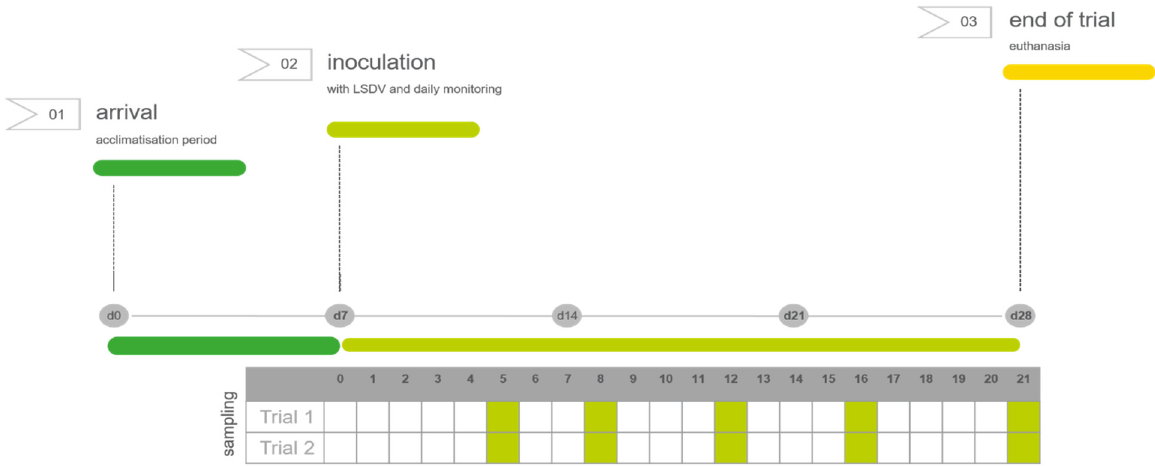
Figure 1. Experimental set-up: Following 7-day acclimatization (dark green), the animals were infected with LSD/OA3- Ts.MORAN and monitored daily for clinical signs (light green), until the end of the trial (yellow). Sampling was performed on the same selected days for both